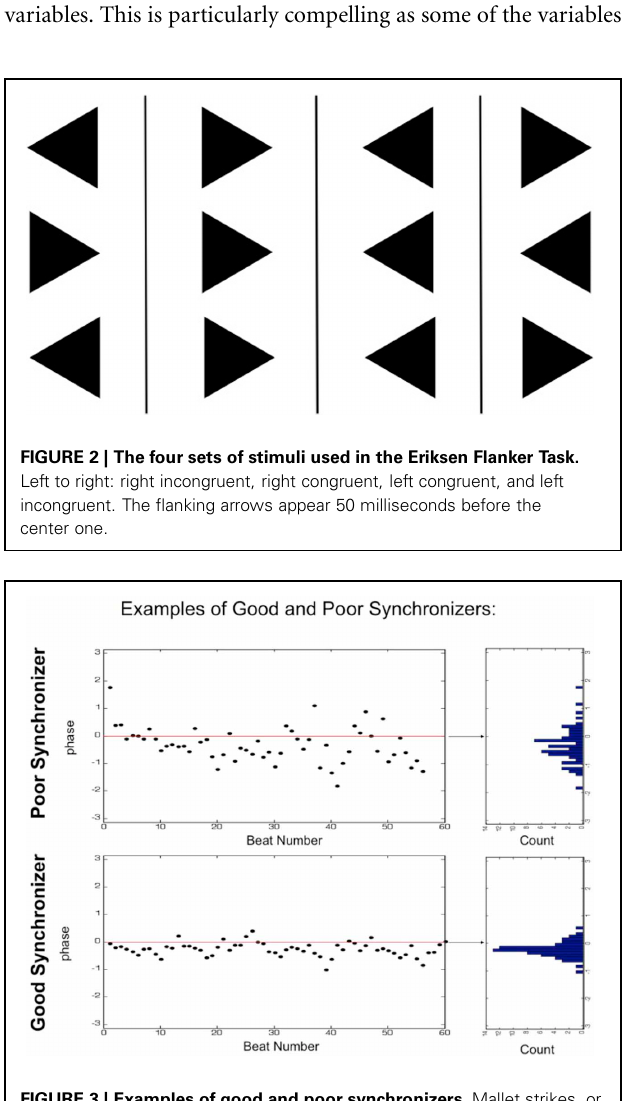
FIGURE 3 | Examples of good and poor synchronizers. Mallet strikes, or onsets, corresponding to one synchronization episode of ∼ 1min. Each dot corresponds to one onset. If a dot is above “0” on the y axis, the corresponding mallet strike took place after that of the leader, if a dot is below “0,” the corresponding mallet strike took place before it. The right panel displays the spread of the phases. The good synchronizer (bottom) had very little spread relative to the poor synchronizer (top) . This spread was quantified using vector strength analysis